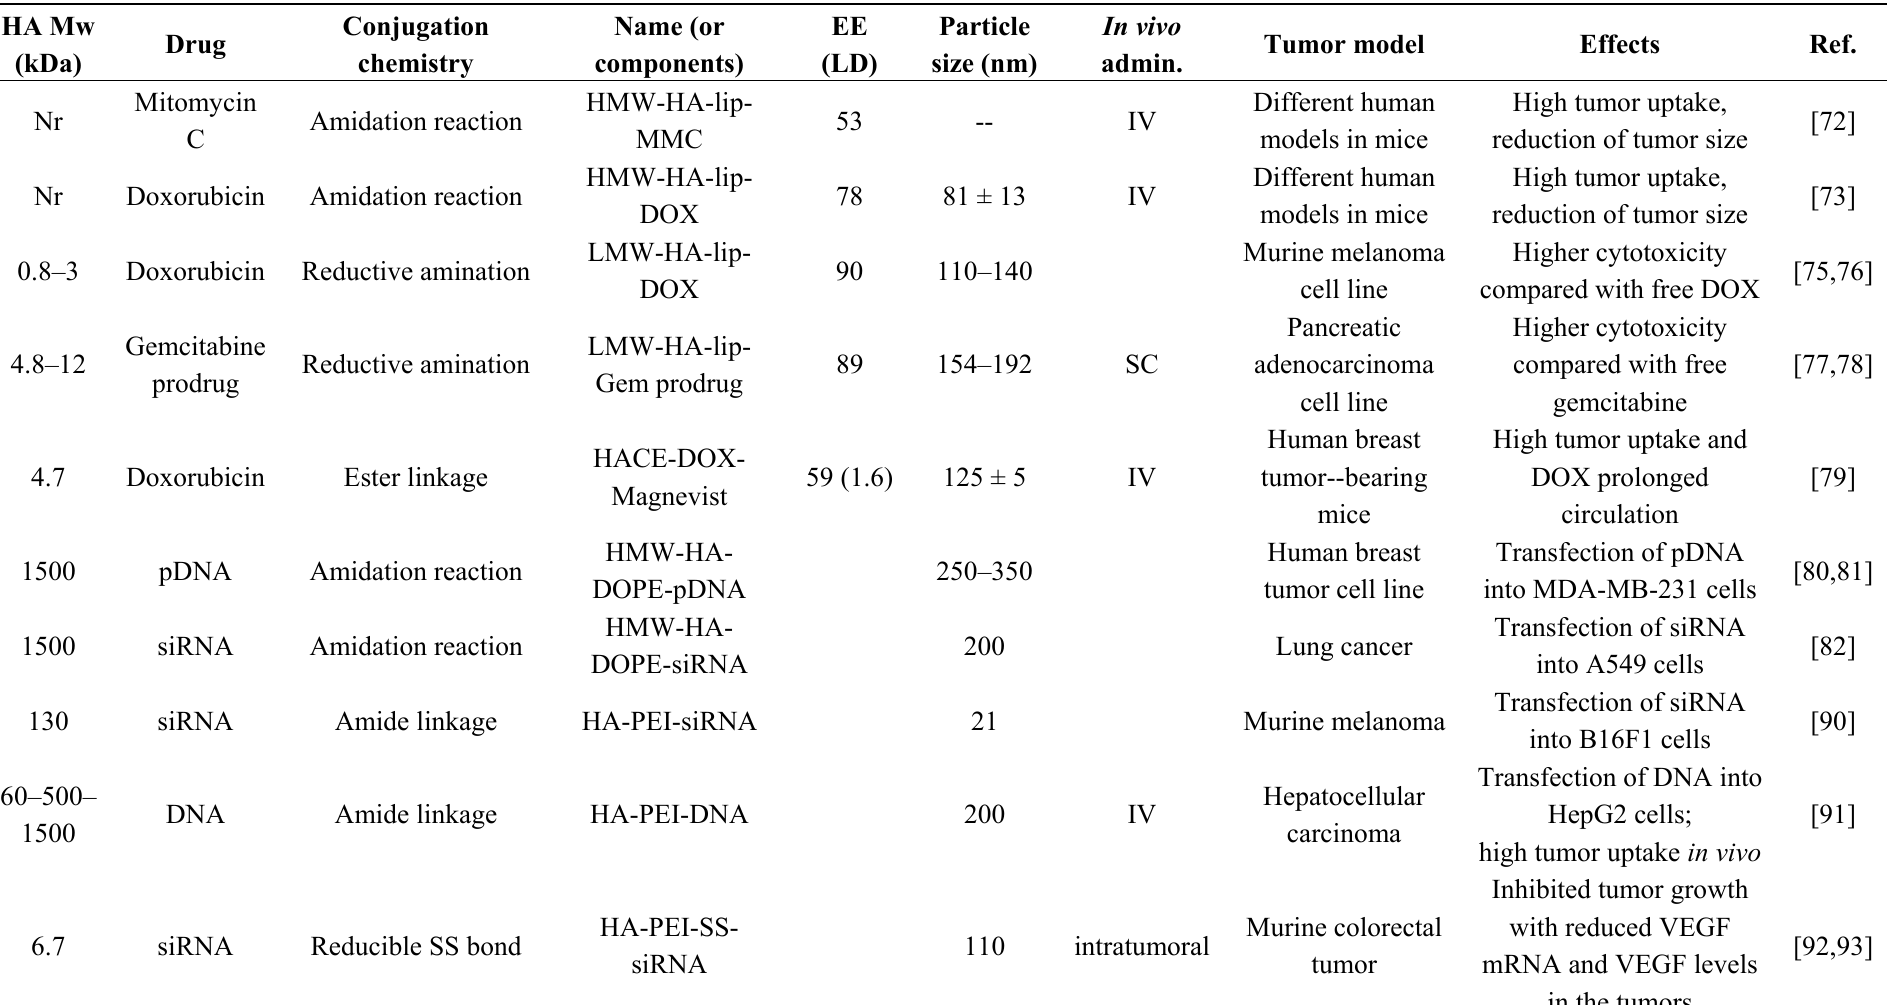
Table 3. Summary of the characteristics of the principal HA-liposome, polymersome, micelle and lipoplex